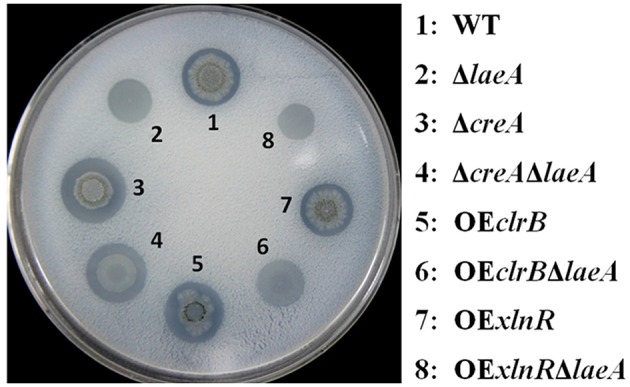
Cellulolytic phenotype of WT and various mutants. Colony morphology of 4-day-old cultures on Vogel's medium agar added with 2% cellulose at 30°C. For WT, ΔlaeA, OEclrB, OEclrBΔlaeA, OExlnR, OExlnRΔlaeA, and ΔcreA, 1 μL of conidia solution was dropped onto the agar at a density of 106 conidia mL−1. For ΔlaeAΔcreA, 1 μL of hyphal fragment solution was dropped onto the agar because it cannot generate conidia.